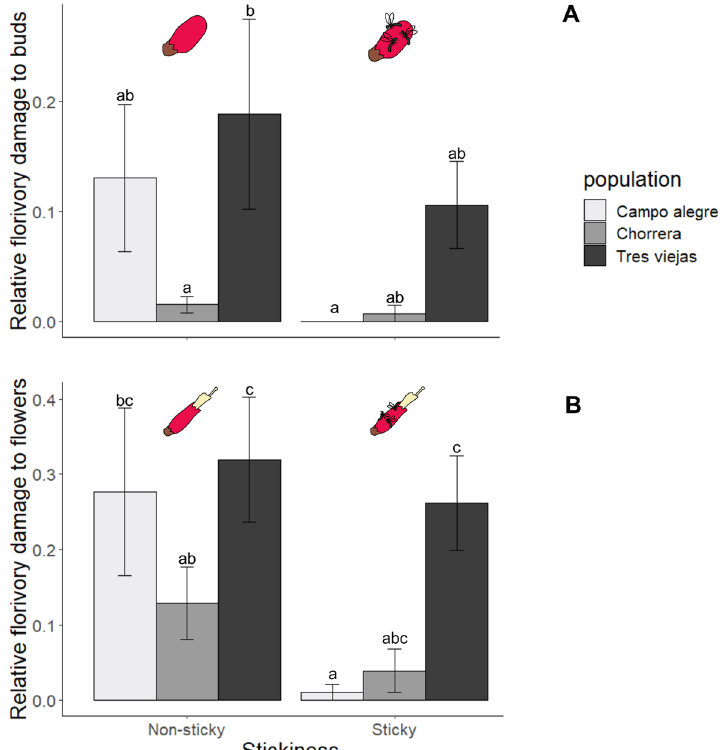
Figure 2. Mean relative proportion of buds ( A ) and flowers ( B ) (± SE) with damage by florivores on sticky and non-sticky plants of Bejaria resinosa in three different populations. Different letters indicate significant differences (Tukey test, significance P =